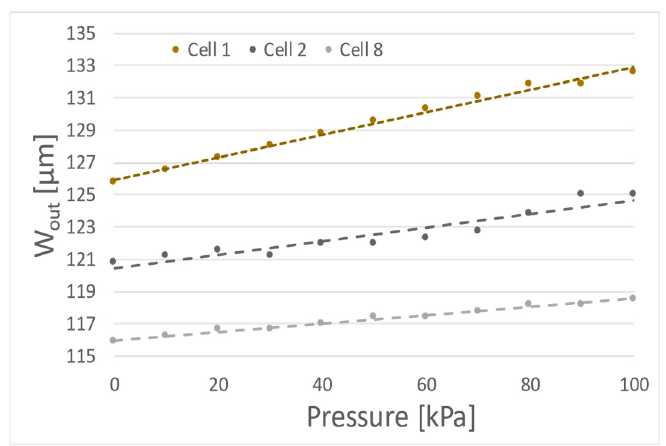
Figure 3. Exemplary dependences of the outside diameter (W out ) of the oocytes as function of the membrane actuation pressure (three specific results).